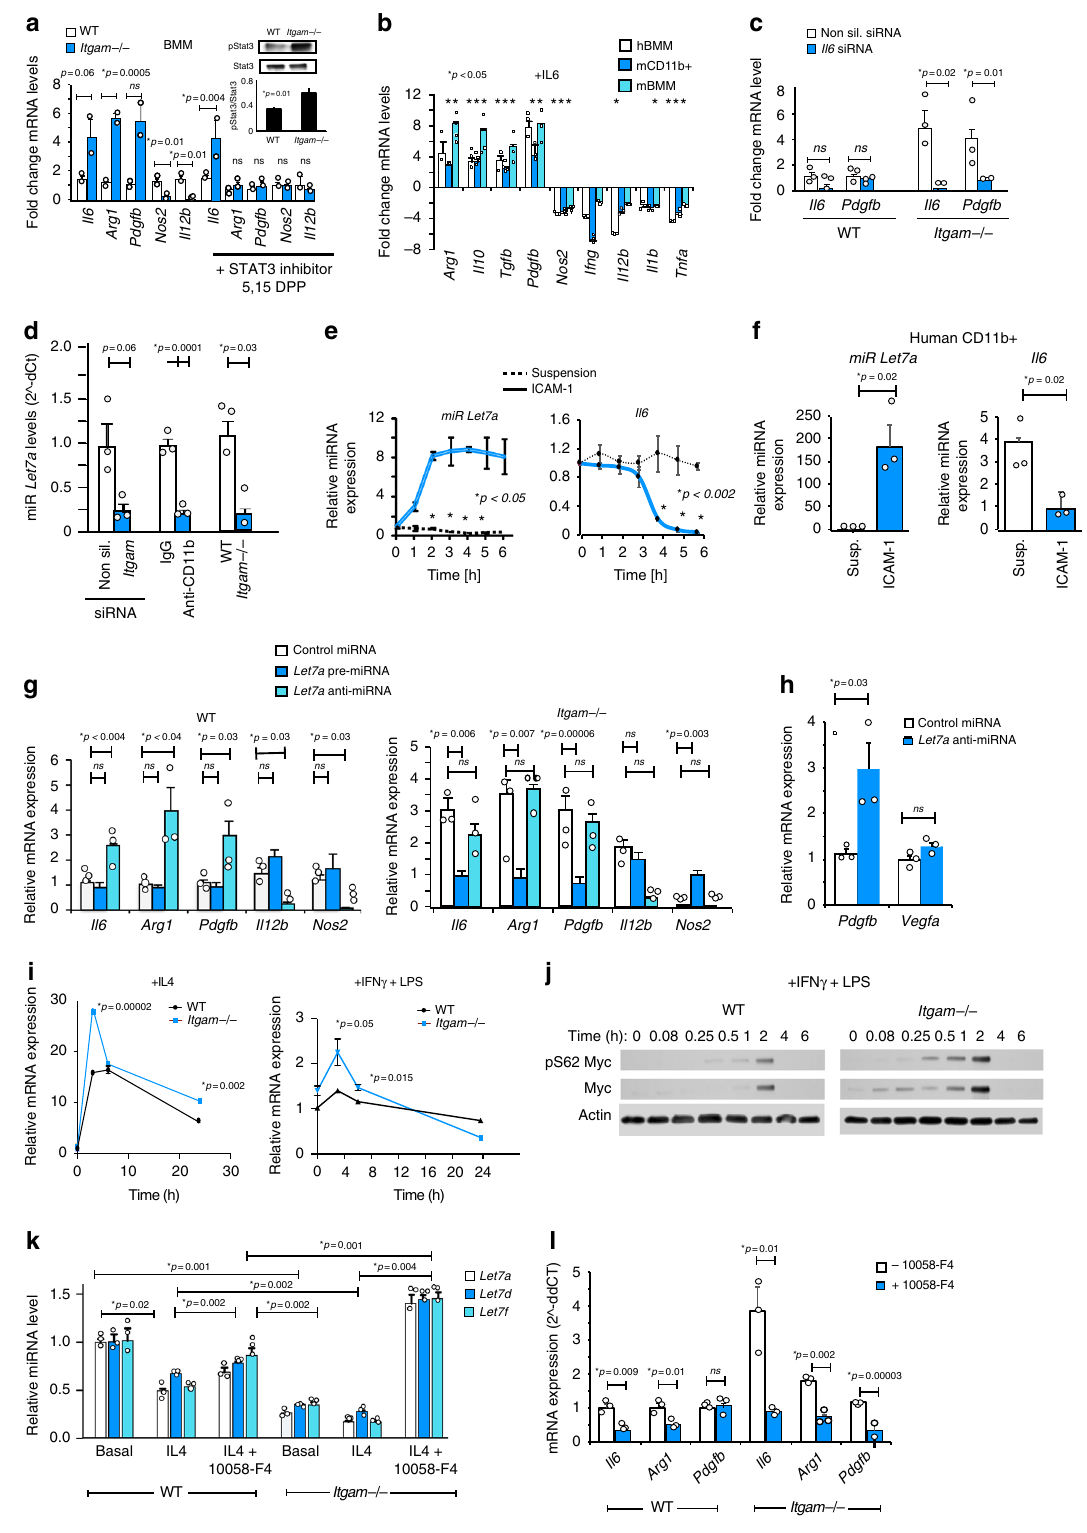
macrophages exhibit constitutively phosphorylated Stat3 (Fig. 3a inset); the high levels of immune suppressive factor expression in Itgam − / − macrophages were reduced to WT macrophage levels by treatment with the Stat3 inhibitor 5,15-DPP (Fig. 3a). Sur- prisingly, however, Stat3 inhibition did not affect the high levels of Il6 expression observed in Itgam − / − macrophages (Fig.